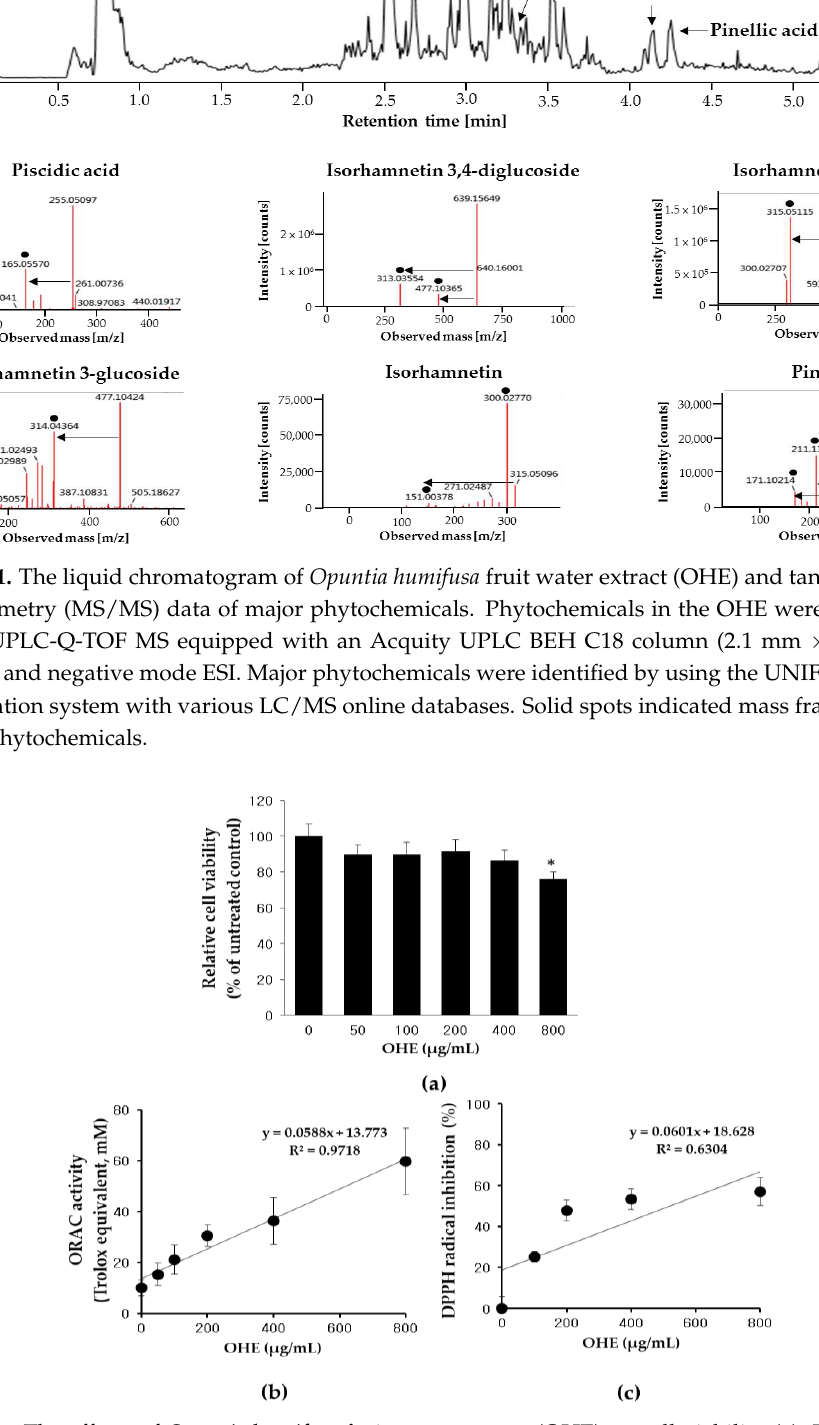
Figure 2. The effects of Opuntia humifusa fruit water extract (OHE) on cell viability ( a ), Regression coefficient graph of the OHE on oxygen radical absorbance capacity (ORAC) ( b ), and DPPH radical-scavenging activity ( c ). Data are presented as the mean ± standard deviation (SD) and analyzed by oneway ANOVA followed by Dunnett ’ s test. * p < 0.05 vs. control group.